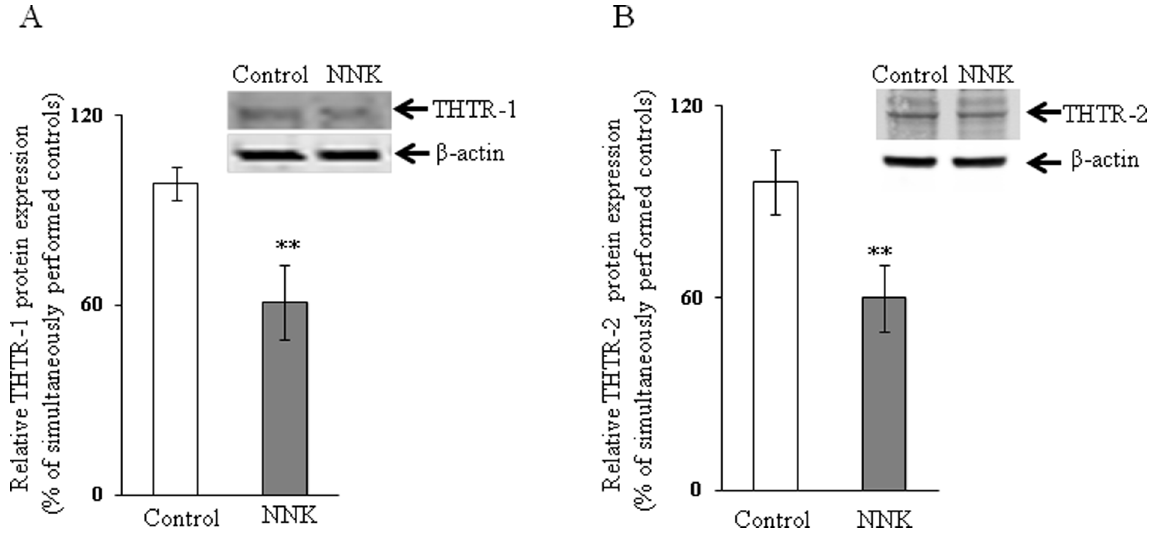
Figure 2. Effect of chronic exposure of pancreatic acinar 266-6 cells to NNK on the level of expression of THTR-1 and THTR-2 proteins. Western blot was performed on whole cell proteins (60 m g) isolated from NNK exposed and control 266-6 cells as described under ‘‘Materials and Methods’’. A and B: blots were incubated with goat polyclonal THTR-1 and THTR-2 antibody respectively. Data are mean 6 SE of at least 3 independent experiments and were normalized relative to b -actin protein expression. ** P , 0.05.